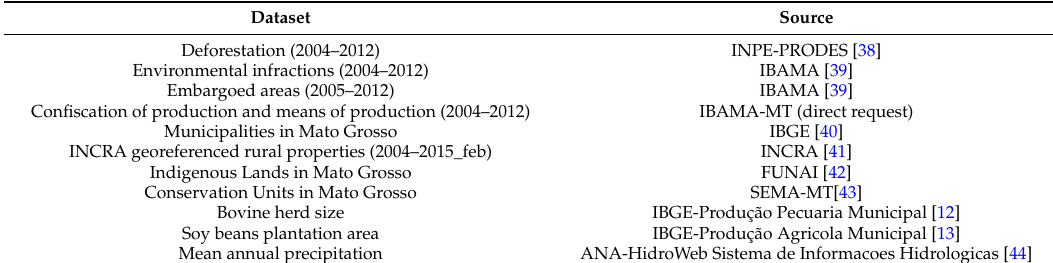
Table 1. Datasets